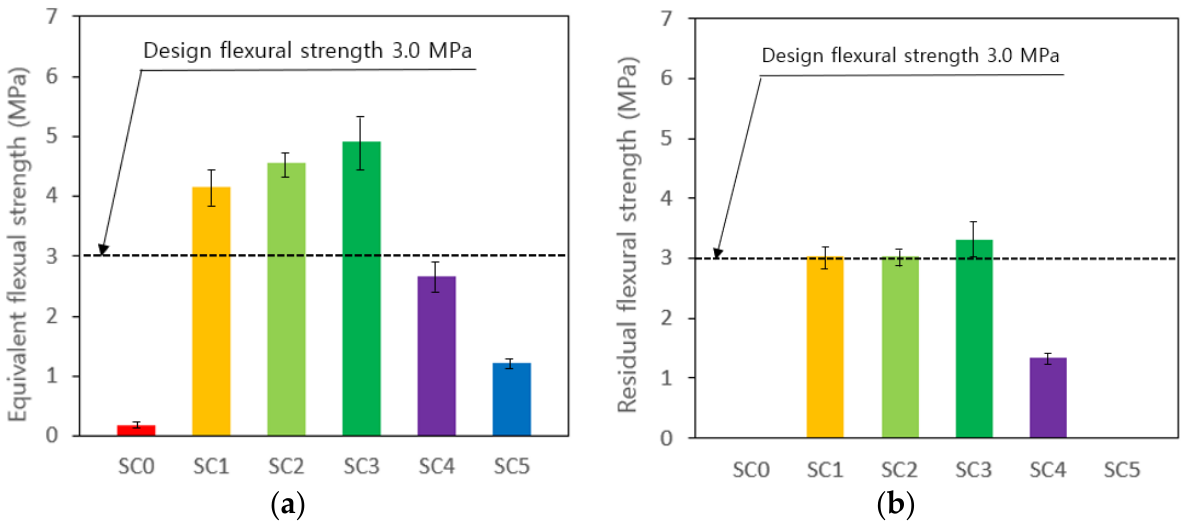
Figure 8. Variation of calculation results of ( a ) equivalent flexural strength, and ( b ) residual flexural strength.